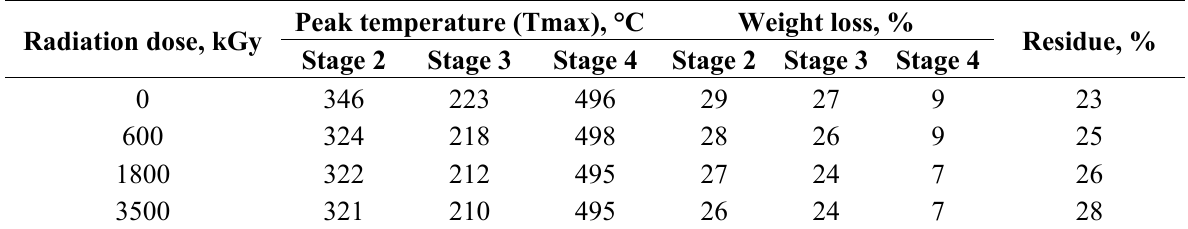
Table 1. Temperature intervals, weight losses and residues of